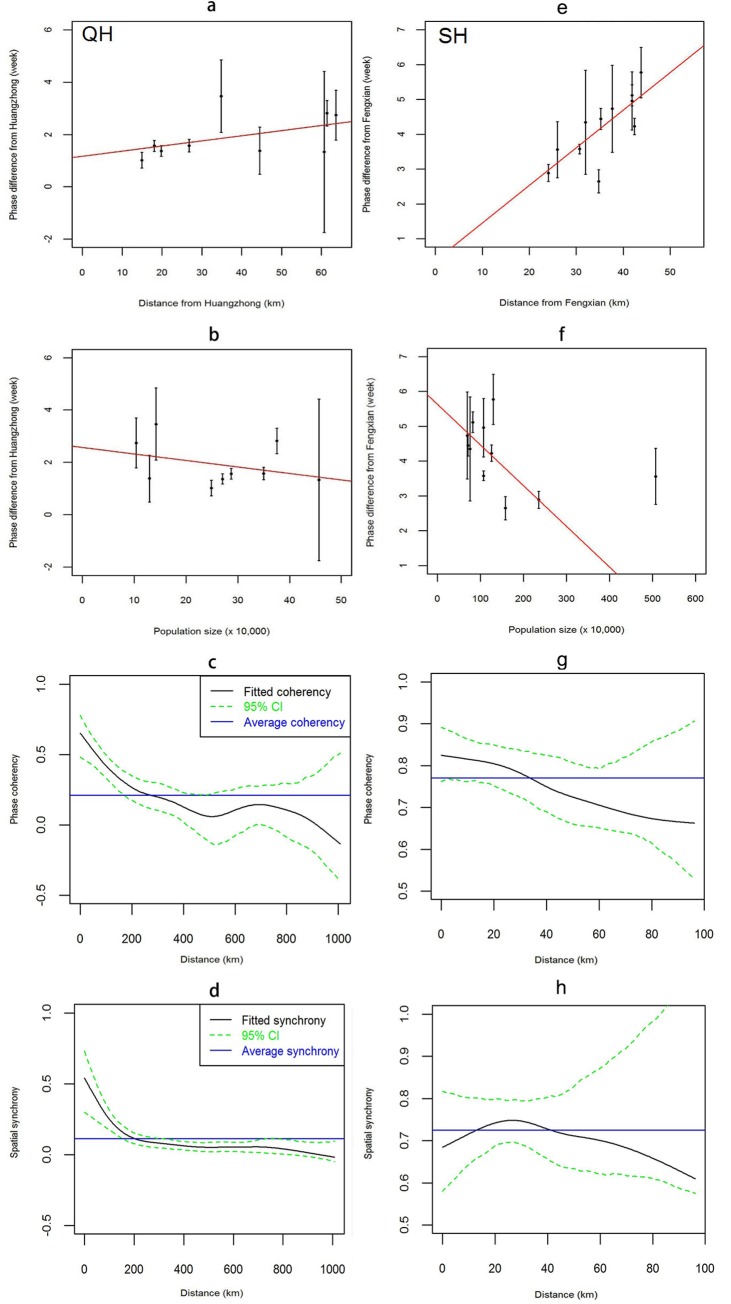
Phase difference, spatial synchrony, and phase coherence plots.a/e. Mean phase difference from Huangzhong and Fengxian (as a function of distance from the county). Within 70km of Huangzhong and 50 km of Fengxian, there is an increasing trend in the phase difference with increasing distance (rHZ = 0.456, rFX = 0.760). The error bars are standard deviation from mean phase difference. b/f, Phase difference from Huangzhong and Fengxian (as a function of population size for neighboring counties, within 70 km of Huangzhong and 50 km of Fengxian). There is a decreasing trend of phase difference with increasing population size (rHZ = -0.350, rFX = -0.611). The error bars are standard deviation from mean phase difference. c/g, Phase coherency curve (as a function of distance) of HFMD in Qinghai and Shanghai with 95% confidence limits. d/h, Spatial synchrony curve (as a function of distance) of HFMD with 95% confidence limits in Qinghai and Shanghai. All the plots were created using R software (R Development Core Team 2013).